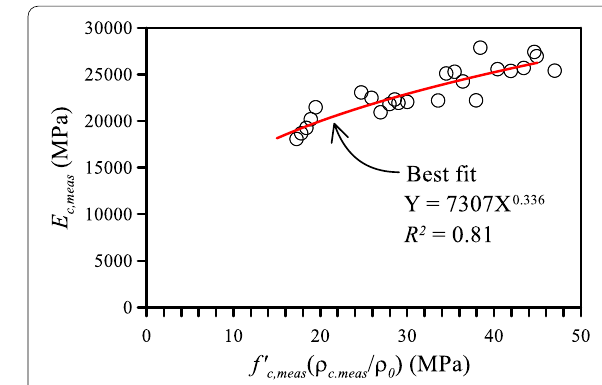
Fig. 5 Effect of f’ c,meas ρ c,meas / ρ 0 on E c,meas and regression